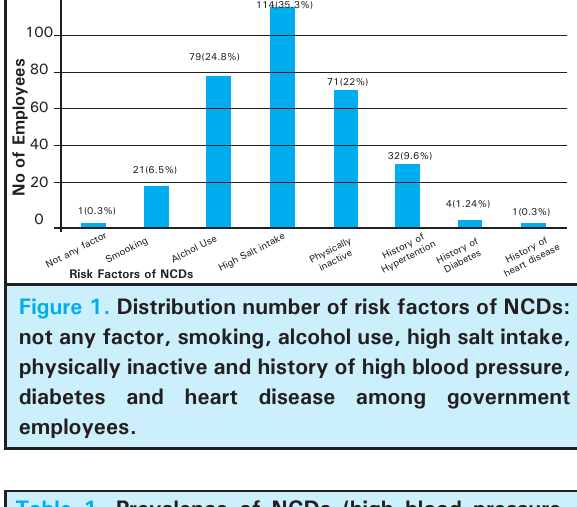
Table 1. Prevalence of NCDs (high blood pressure, diabetes and CVD) among government employees.